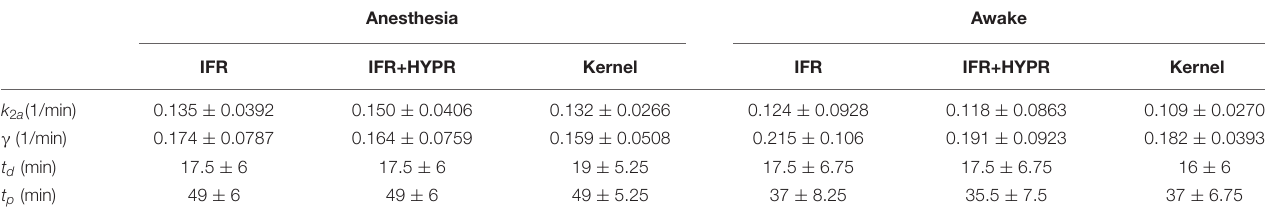
TABLE 4 | Regional striatum k 2 a , γ , t d , and t p parameters calculated with the lp-ntPET kinetic model, using independent frame reconstruction (IFR), independent frame reconstruction with HYPR denoising (IFR+HYPR), and spatiotemporal kernel reconstructions (Kernel), for the anesthetized and awake